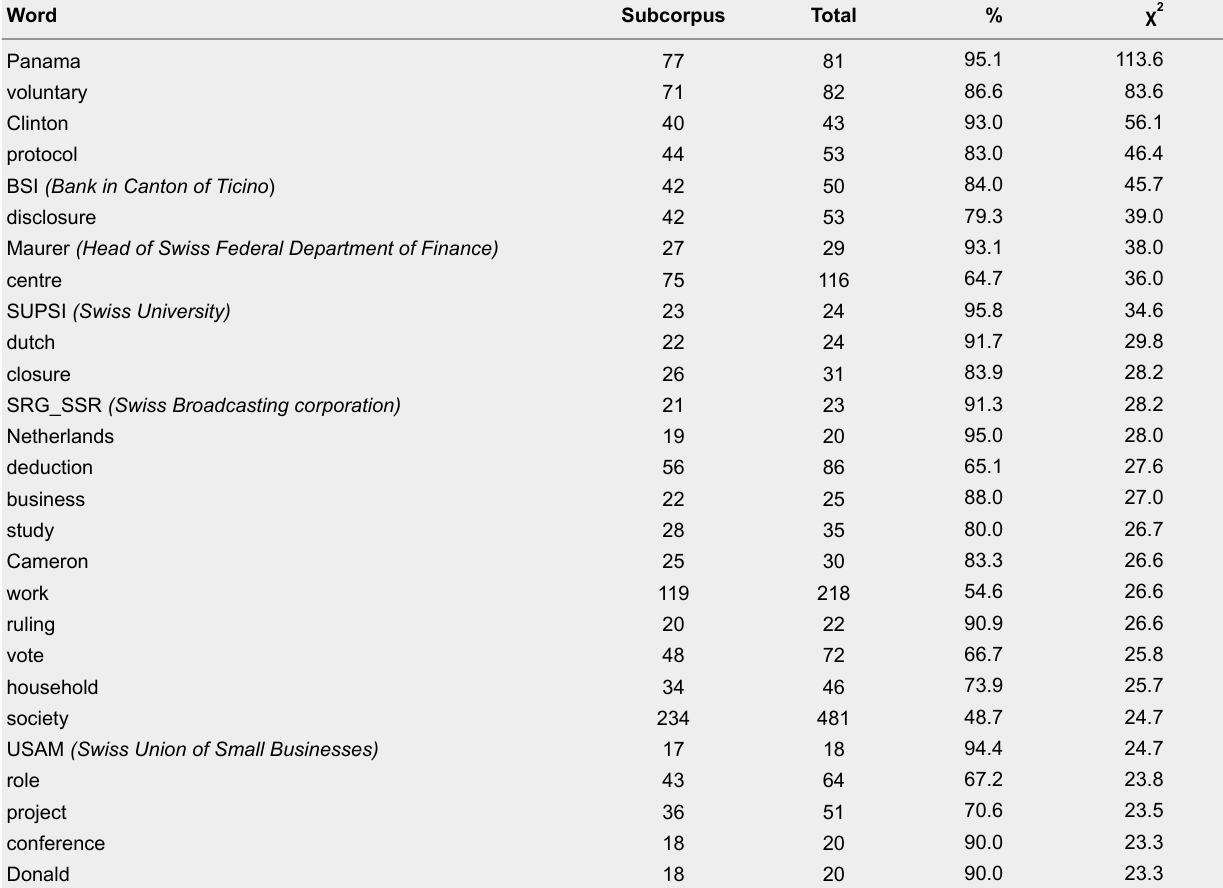
Specificity Analysis: Overused Words in Switzerland Between 2015 and 2016